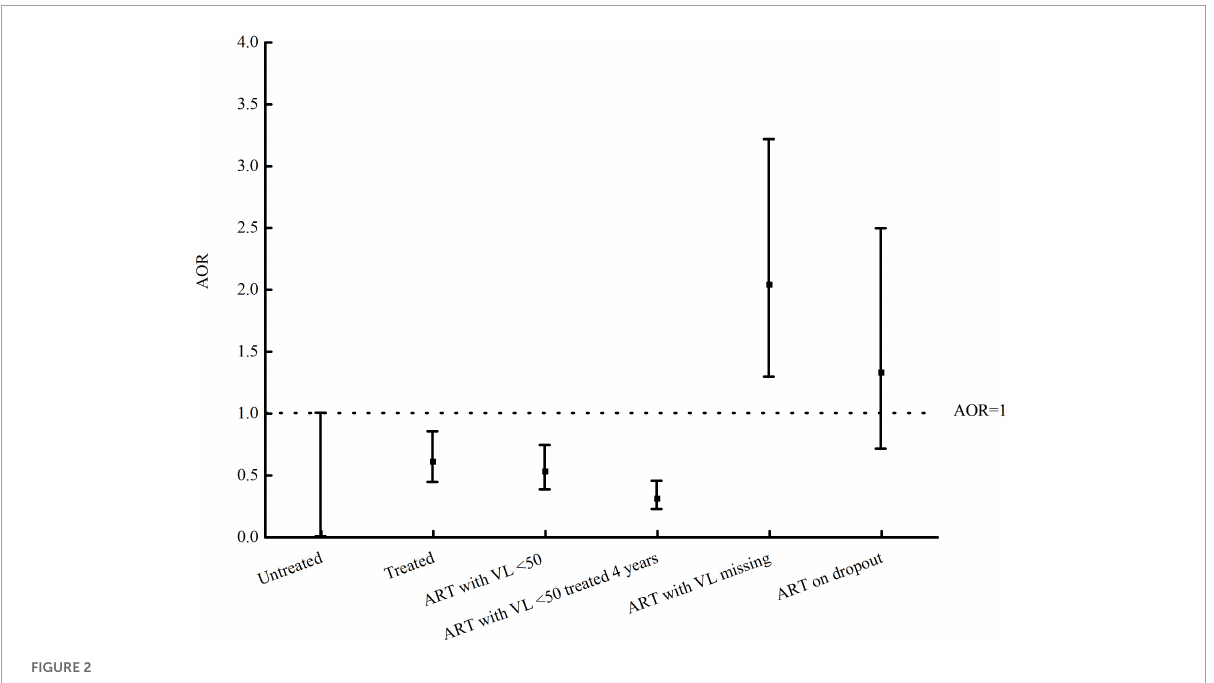
FIGURE2 AOR values of stratified analysis of genetic transmission network in Guangxi of China.